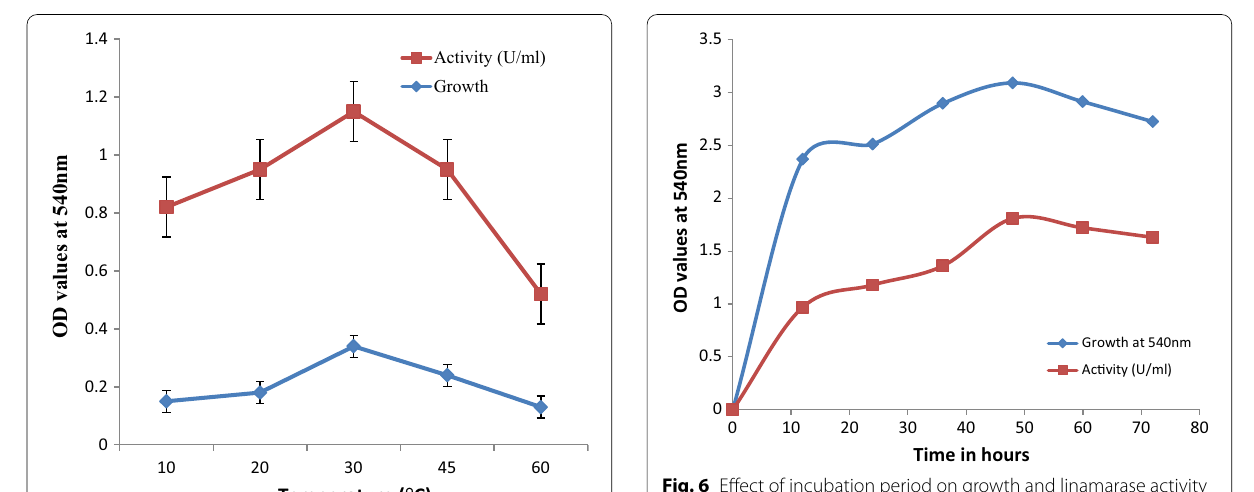
Fig. 6 Effect of incubation period on growth and linamarase activity L.